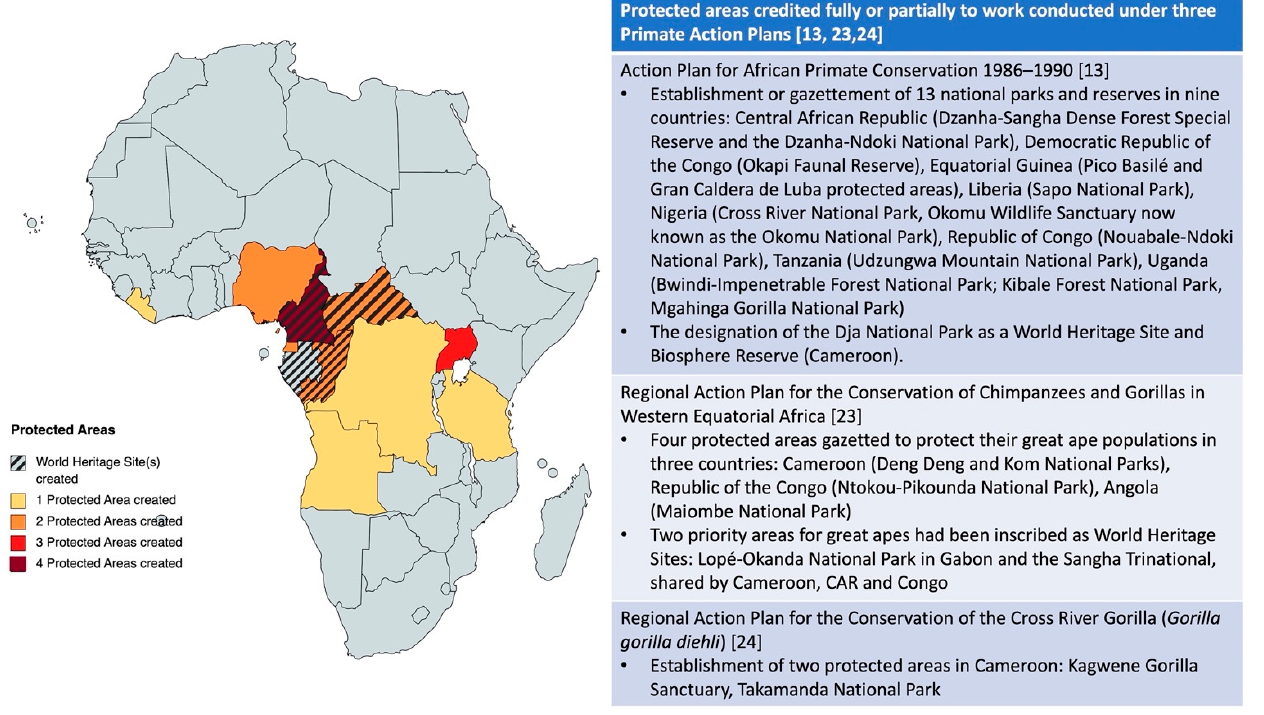
Figure 5. Geographic spread of protected areas established which have been credited partially to three Primate Action Plans [13,23,24].